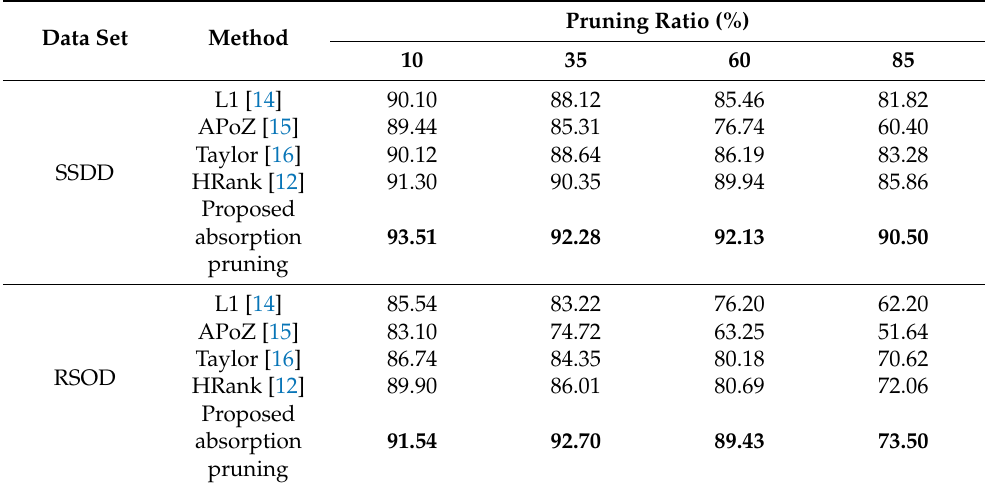
Table 4. Results for experimental comparison of absorption pruning with other pruning methods.